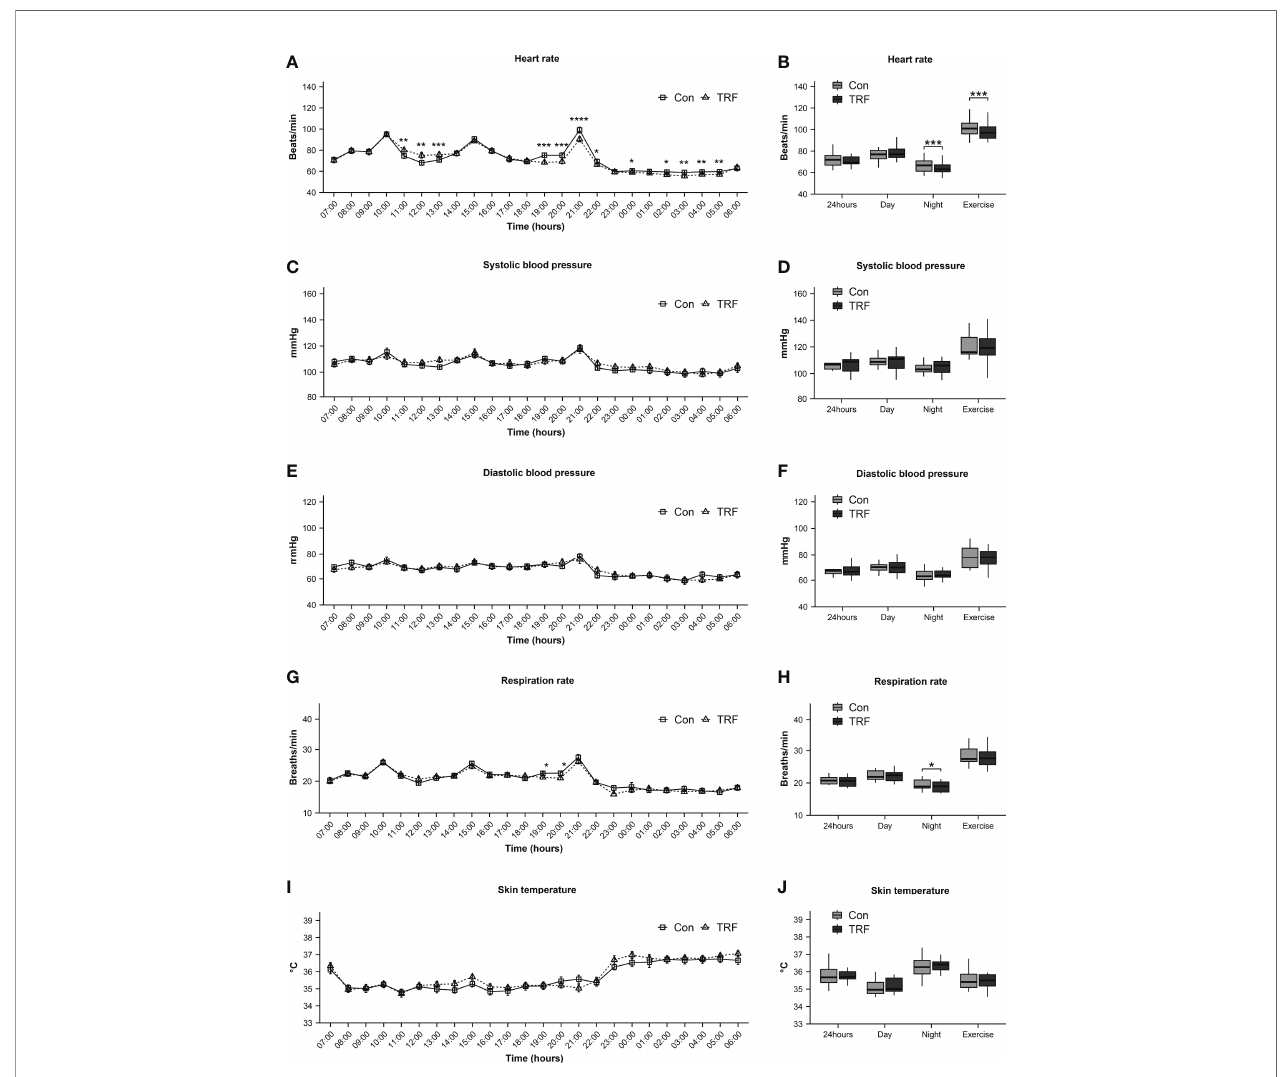
FIGURE 6 | Heart rate (A, B) , systolic blood pressure (C, D) , diastolic blood pressure (E, F) , respiration rate (G, H) , and skin temperature (I, J) between TRF and control group. Data are mean ± SEM, *P <0.05, **P<0.01, ***P<0.001,****P ≤